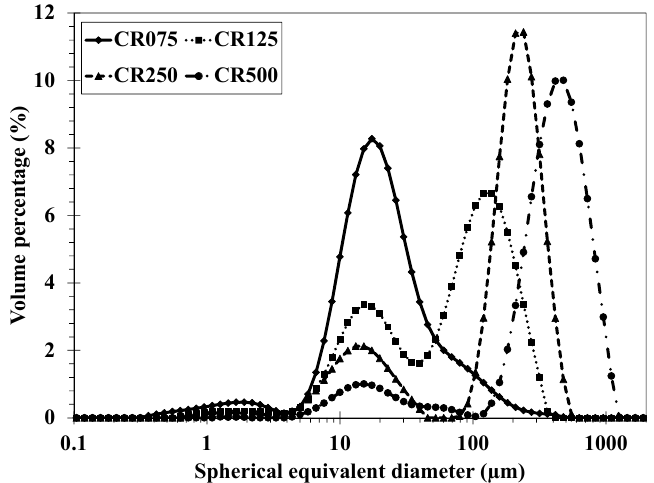
Figure 2. Particle size distribution of initial cassava flours (CR075, CR125, CR250 and CR500 are cassava flour with the particle sizes of under 75 µm, 75–125 µm, 125–250 µm and 250–500 µm, re- spectively).